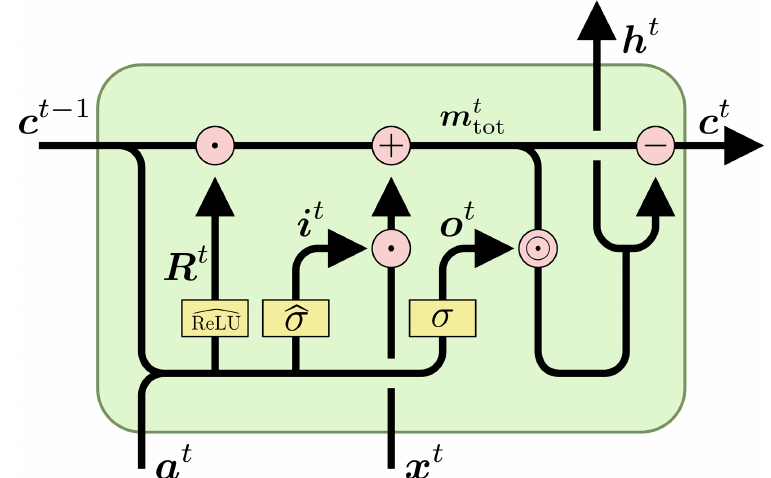
Figure B1. A single time step of a mass-conserving LSTM, with time steps marked as superscripts for clarity. As in Fig. A1, c t , a t , x t , i t , o t , and R t are the cell states, conserved inputs, input features, input fluxes, output fluxes, and reshuffling matrix at time t , respectively. σ represents a standard sigmoid activation layer, and (cid:98) σ and (cid:92) ReLU represent normalized sigmoid activation layers and normalized ReLU activation layers, respectively. Addition and subtraction signs represent element-wise addition and subtraction, respectively; (cid:12) represents element-wise multiplication; and the · sign represents the dot